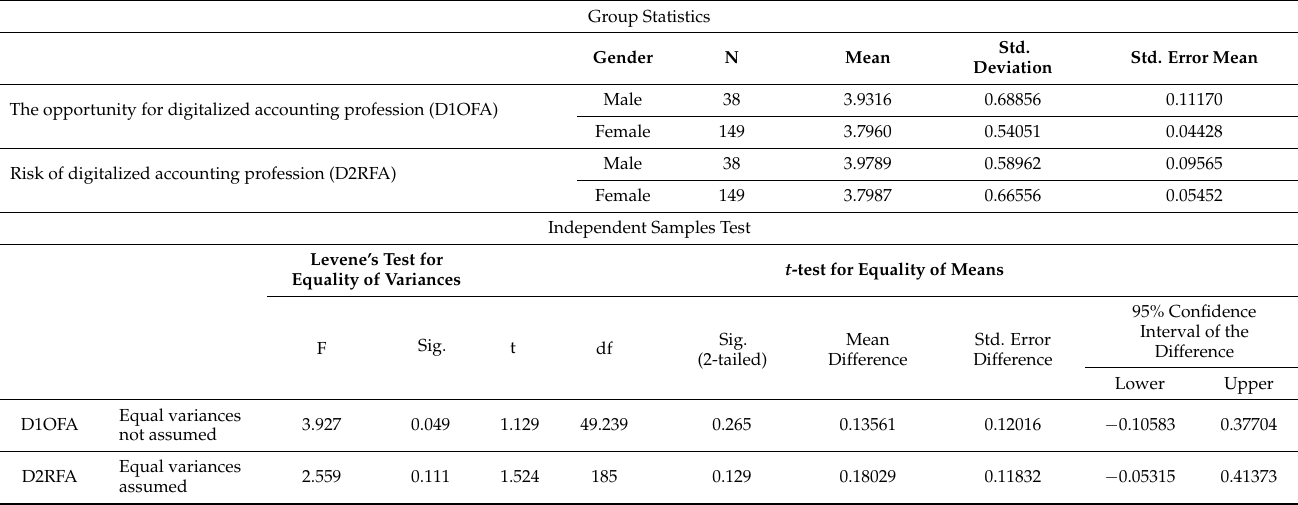
Table 5. Independent t -test